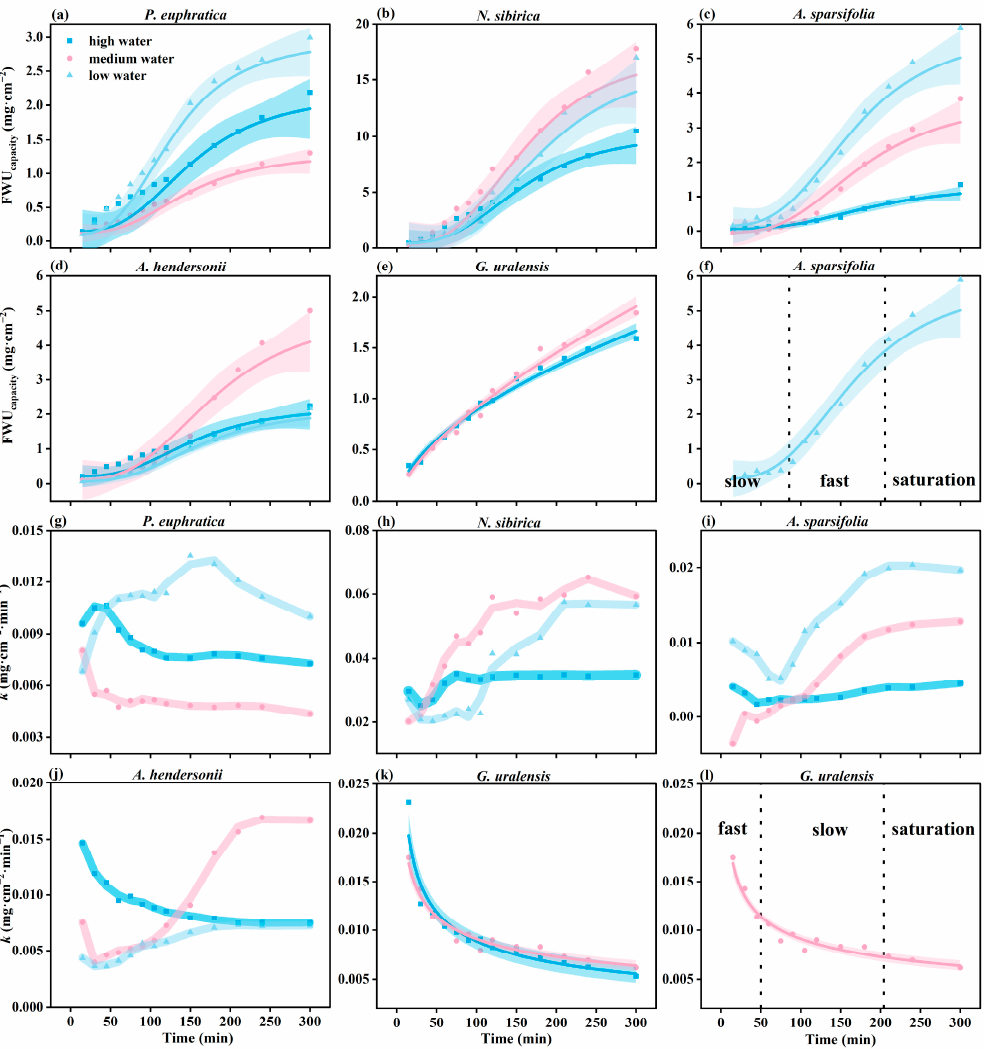
Figure 4. The variation in FWU capacity and k over time ( a – l ) under different water gradients. The parameters fit using each model are presented in Table S2 (N =